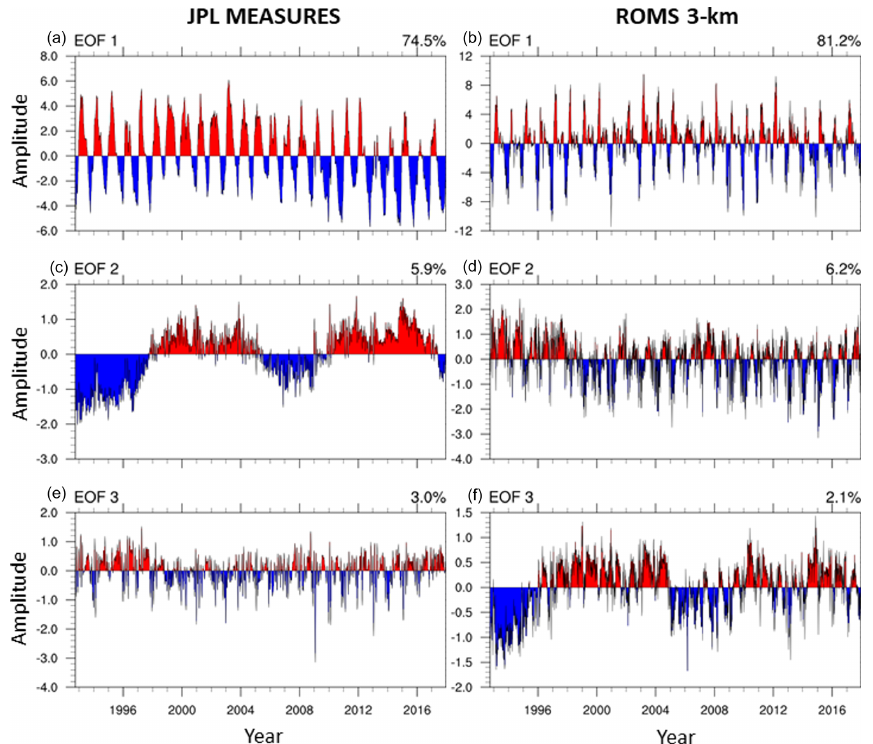
Figure 3. Time series of the amplitudes associated with the three main normalized spatial EOF components derived during the 1993–2017 period from the SSHA from the JPL MEASURES gridded product (a, c, e) and the SSH results of the AdriSC ROMS 3km model (b, d, f)